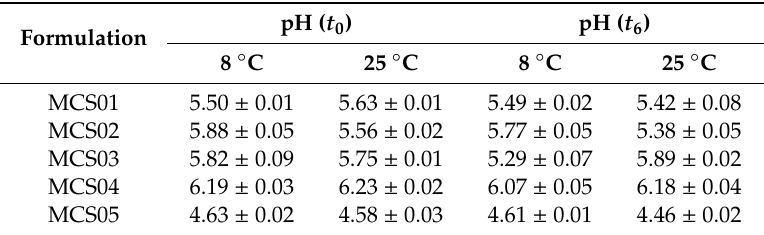
Table 2. pH values in samples stored at 8 and 25 ◦ C, 24 h after elaboration ( t 0 ) and after 6 months ( t 6 ). Values represent mean ± SD ( n = 3).